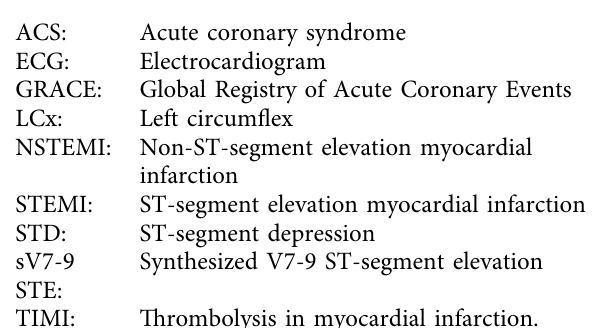
Supplemental Table 1: synthesized V7-9 characteristics